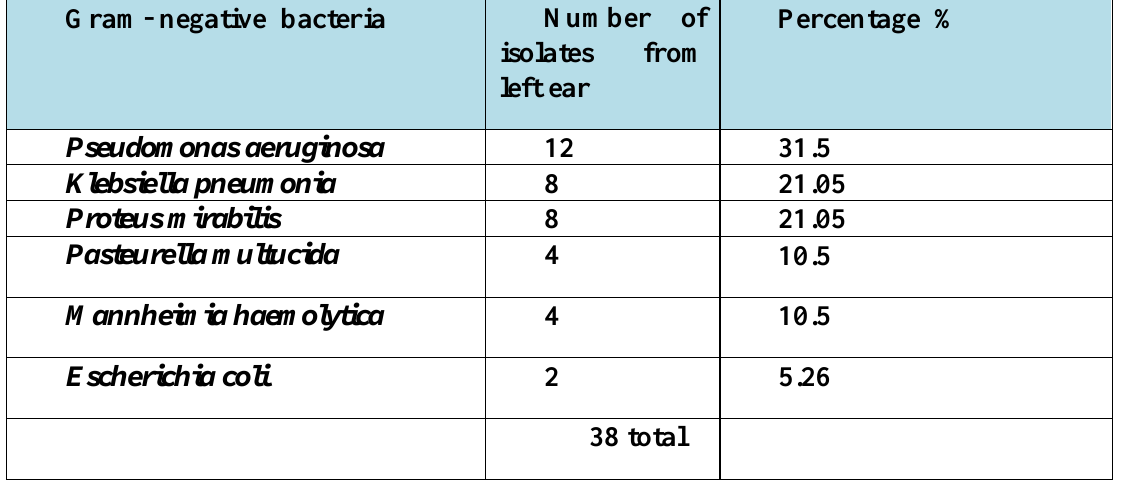
Table 6: Numbers of gram negative bacteria from infected left ear in sheep Gram- negative bacteria Number of isolates